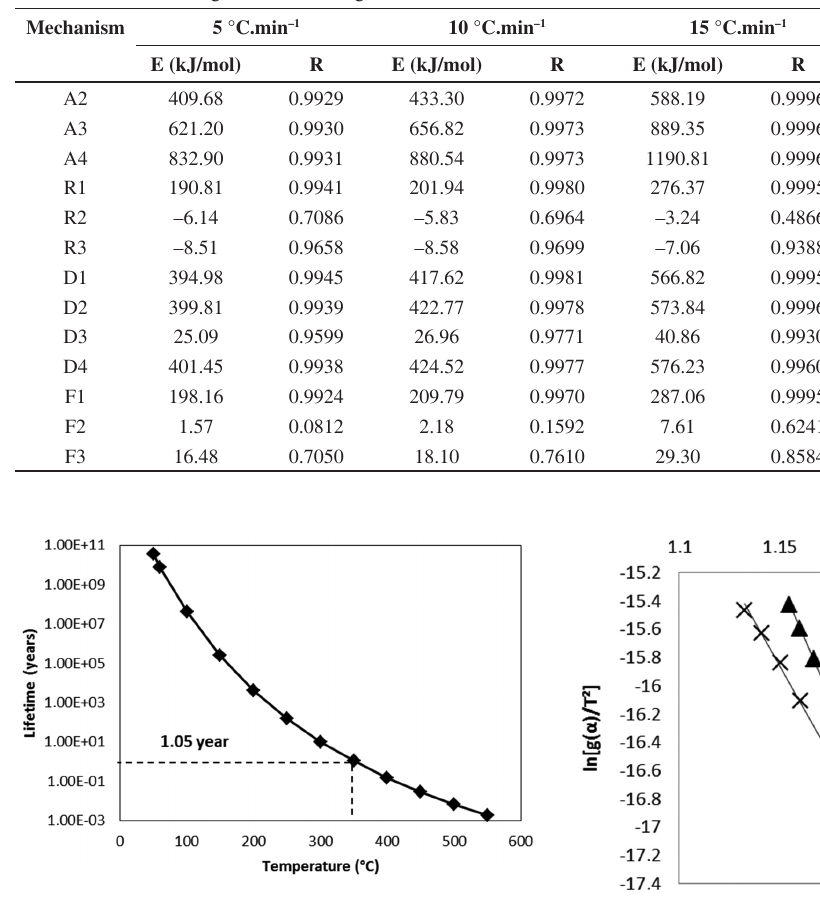
Figure 11. Lifetime versus necessary temperature for the PEEK decomposes in 5%.